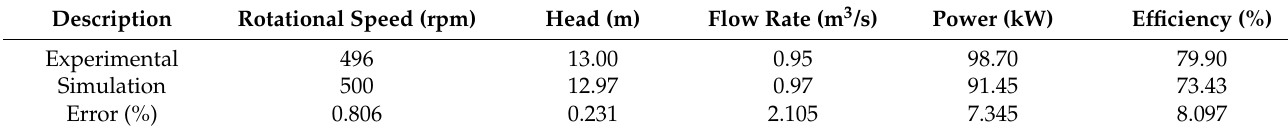
Table 5. Comparison of experimental and simulation test results of the tubular turbine.